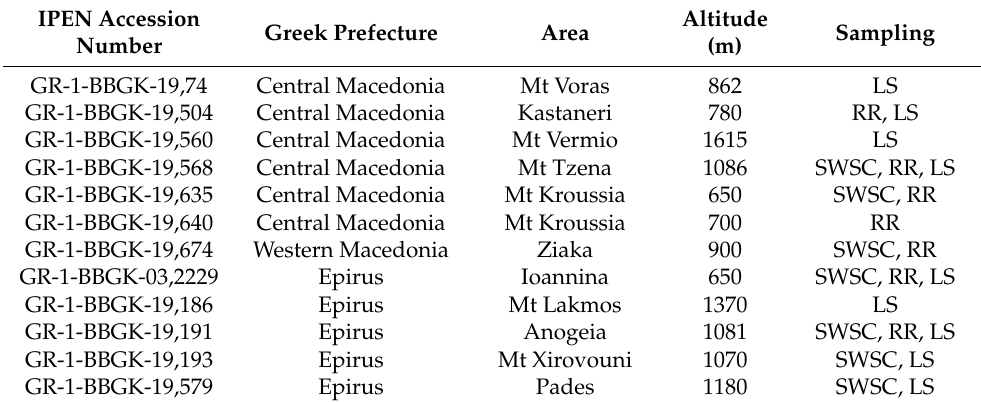
Table 7. Selected Rosa canina genotypes sampled from various mountainous habitats of northern Greece assigned with different IPEN (International Plant Exchange Network) accession numbers. IPEN Accession Greek Prefecture